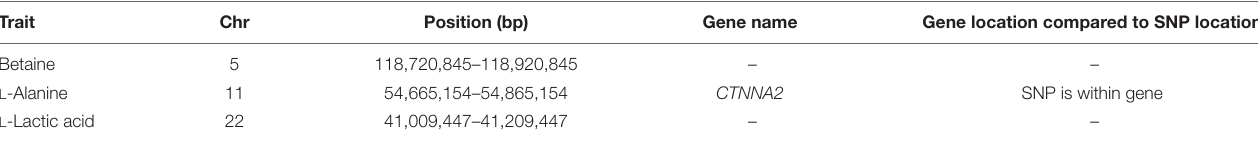
of a candidate gene within 200-kbp distance, however, SNP rs42009425 associated with L -lactic acid was reported to be associated with clinical mastitis in French Holstein cattle (Marete